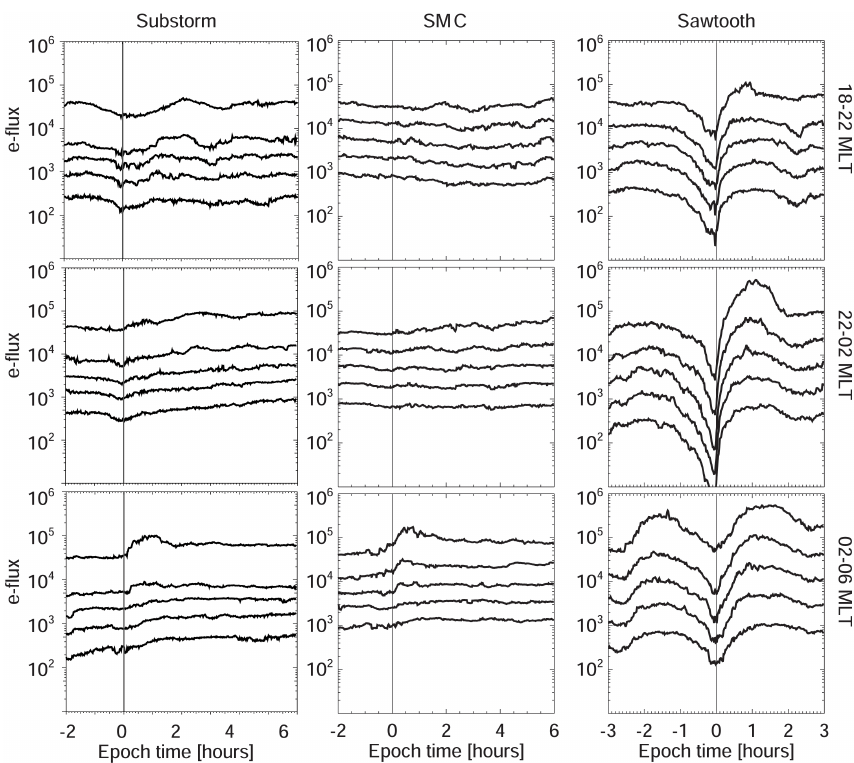
Fig. 3. Superposed epoch analysis results of the geosynchronous electron fluxes at 18:00–22:00MLT, 22:00–02:00MLT, and 02:00– 06:00MLT for the isolated substorms (left panels), SMC events (middle panels) and for the sawtooth events (right panels). The electron fluxes are shown in the range 50–315keV (five lowest energy channels) in units of 1/cm 2 /s/sr/keV. The vertical black line marks the zero epoch, which is defined as the ground-based substorm onset for the SMC periods and the geostationary orbit injection onset for the sawtooth